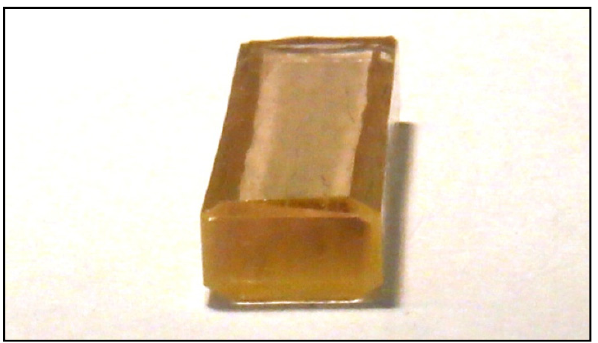
Figure 37. Rectangular Nd:YAG crystal with hydrothermally-grown Sm:YAG layer for parasitics and amplified-spontaneous-emission suppression. After the growth of the layer, the Sm:YAG is removed from the end faces by polishing and the surfaces dielectric coated. Appl. Sci. 2016 , 6 , 23 54 of 73